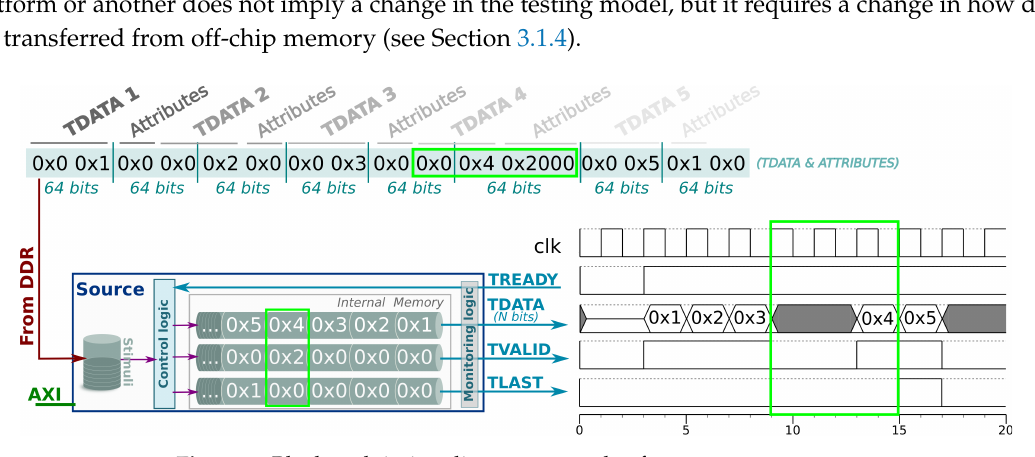
Figure 3. Block and timing diagram example of a source component.